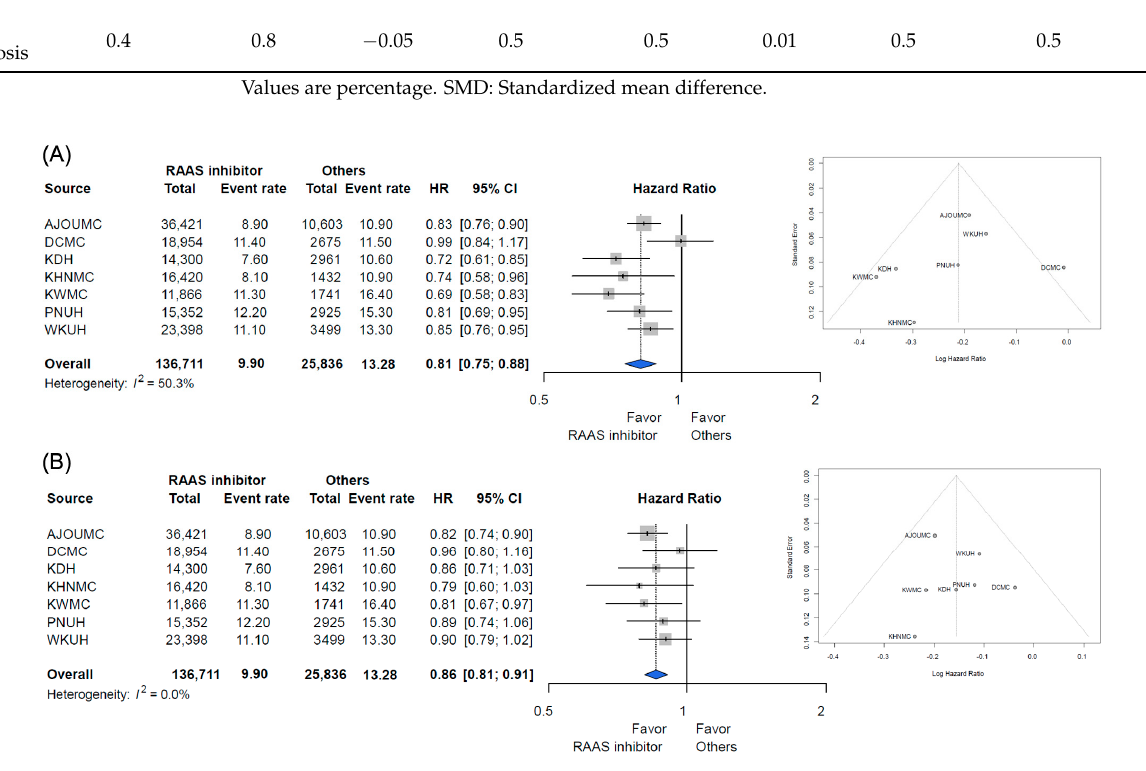
Figure 2. Incidence rate of all cancer in the entire cohort ( A ) adjusted for sex and age and ( B ) propensity score stratified. Abbreviations: AJOUMC, Ajou University Medical Center; DCMC, Daegu